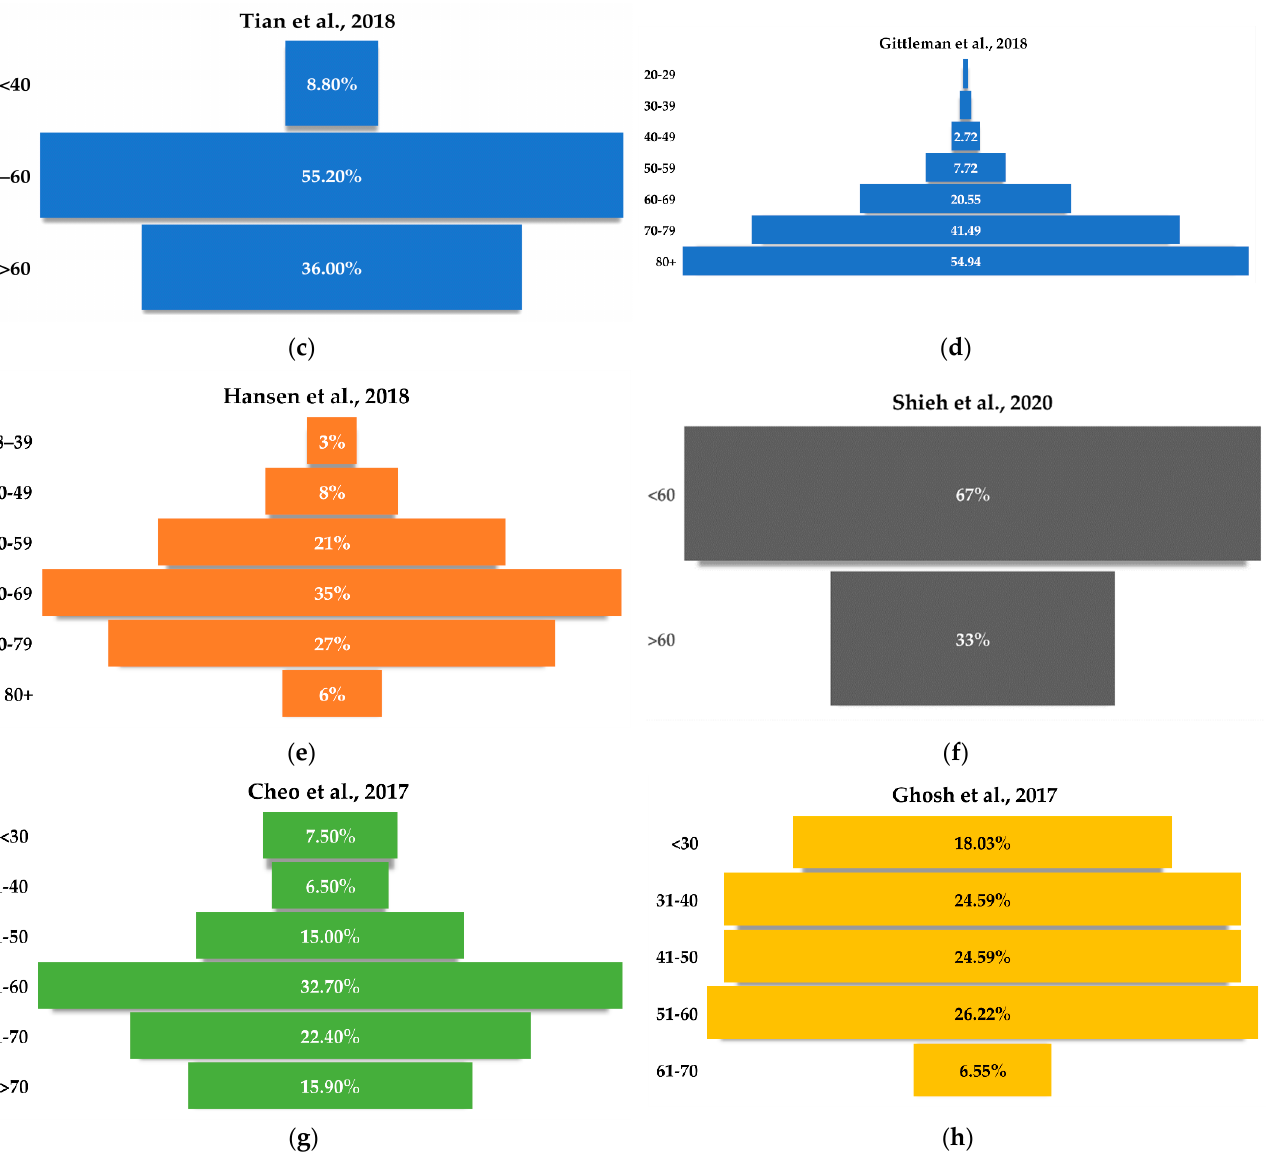
Figure 2. Age-related incidence of GBM in ( a ) [32], ( b ) [105], ( c ) [85] ( d ) [92] the USA, ( e ) Denmark [31], ( f ) Taiwan [106], ( g ) China [107], and ( h ) India [25]. Based on the Central Brain Tumor Registry of the United States (CBTRUS) reports in 2013, 2017, and 2020, it was observed that the incidence of GBM increases with age, peaking at 75–84 years and decreasing after 85 years (Figure 3). Gittleman et al. [92] showed that the incidence rate of GBM increases with